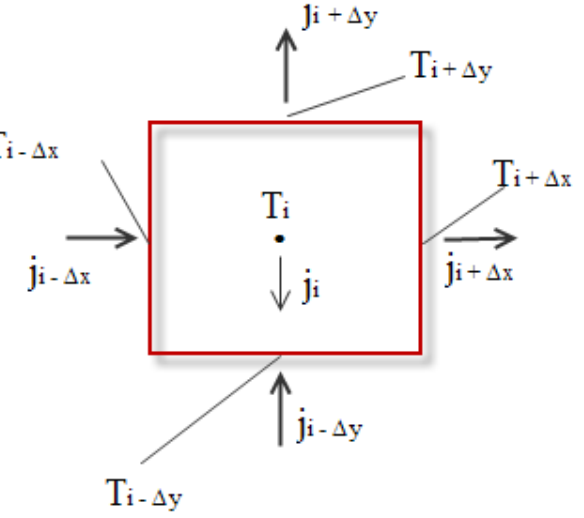
Figure 2. Volume element nomenclature.